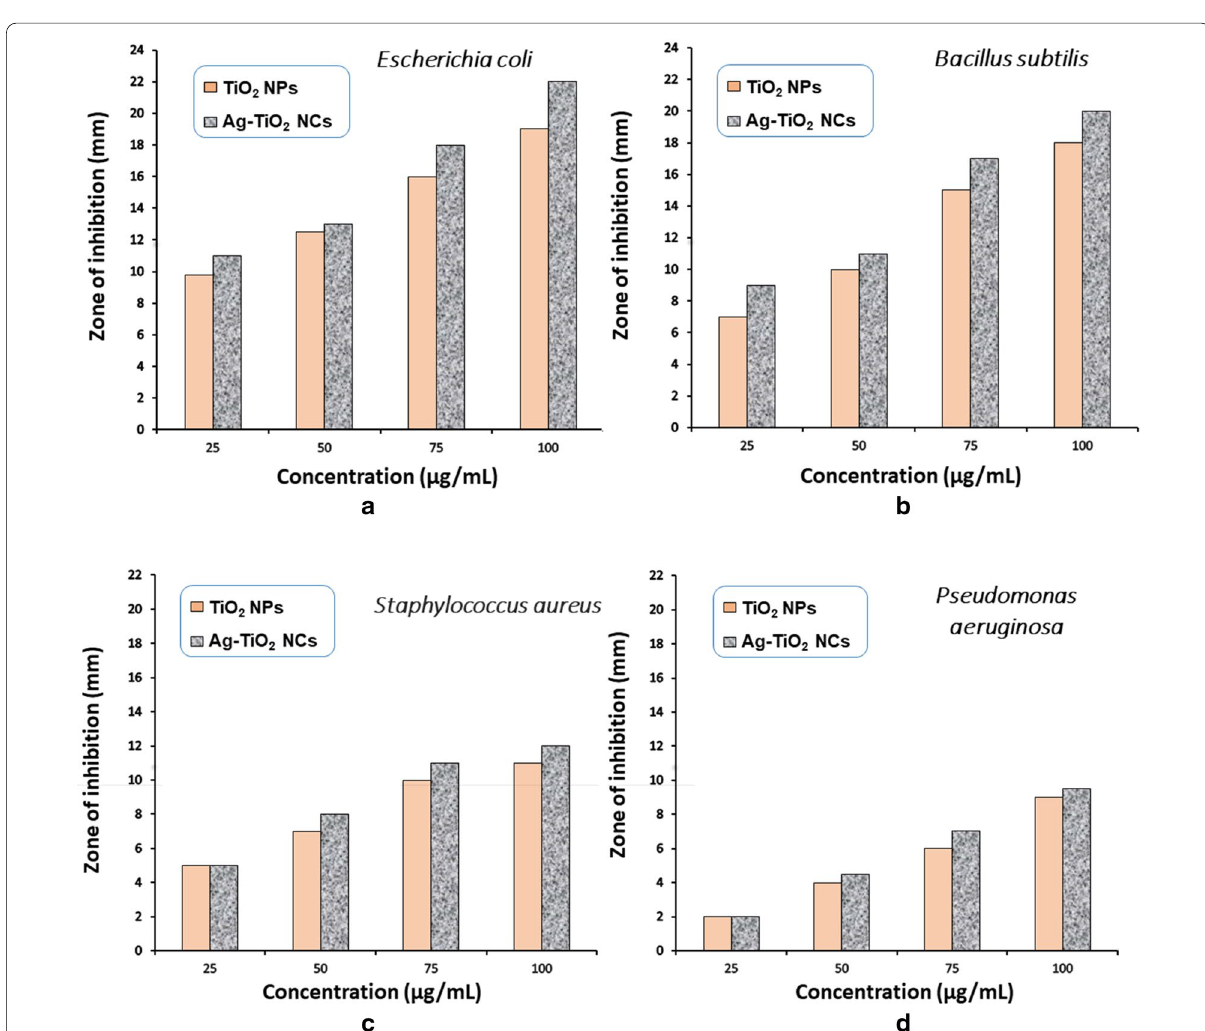
Fig. 6 Antibacterial activity of green-synthesised Ag–TiO 2 NCs and TiO 2 NPs at different concentrations against four pathogens a E. coli , b B. subtilis , c S. aureus and d P. aeruginosa